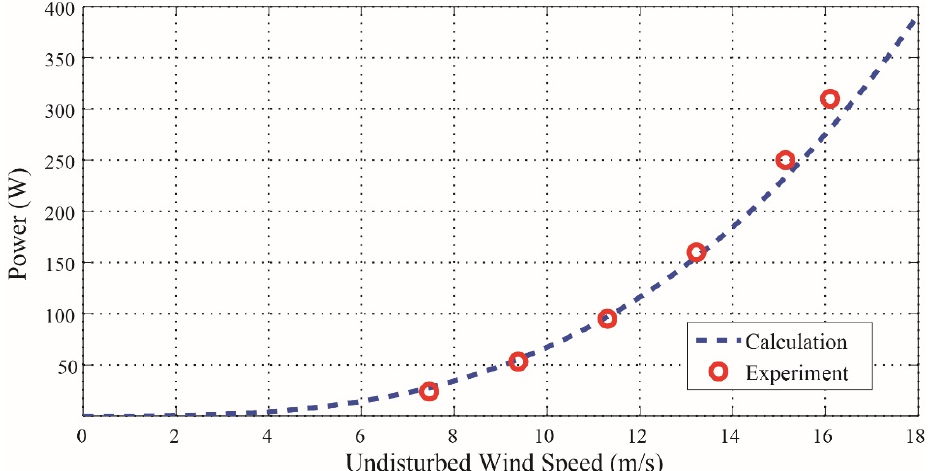
Figure 18. Generated power